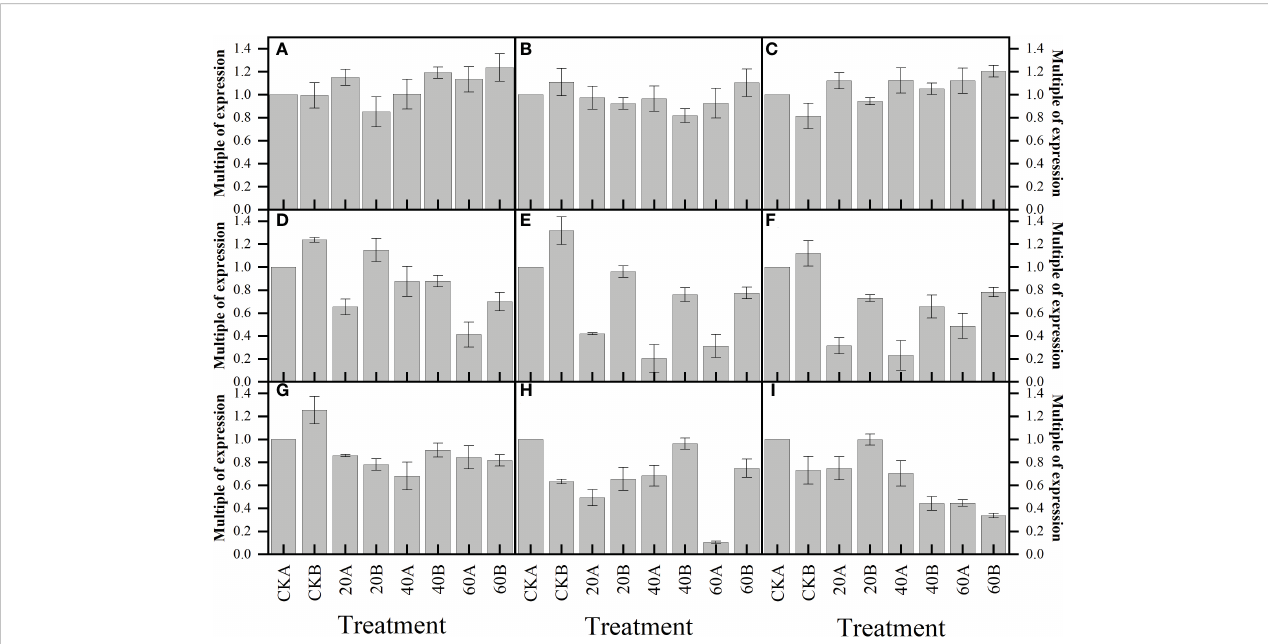
FIGURE 9 Effects of GA 3 application under low light stress on GA-related gene expression levels of different photosensitive inbred lines after shade for 15 days. (A) DELLA1; (B) DELLA2; (C) DELLA3; (D) GID1C1; (E) GID1C2; (F) GID1C3; (G) GA20ox2; (H) KAO1; (I) KAO2. Values are expressed as mean ± SD of three replicates.